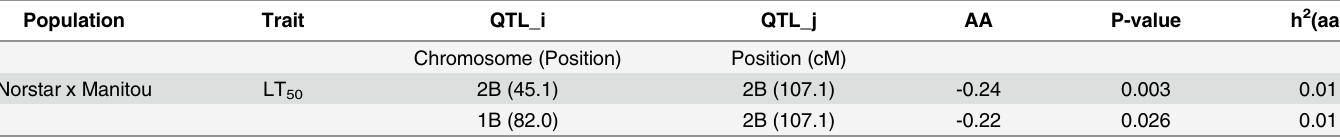
Table 7. Epistatic QTL interactions for LT 50 in Norstar x Manitou detected in controlled Environment Trials. Additive x additive interaction effects (AA) and their heritability h 2 (aa) are shown.